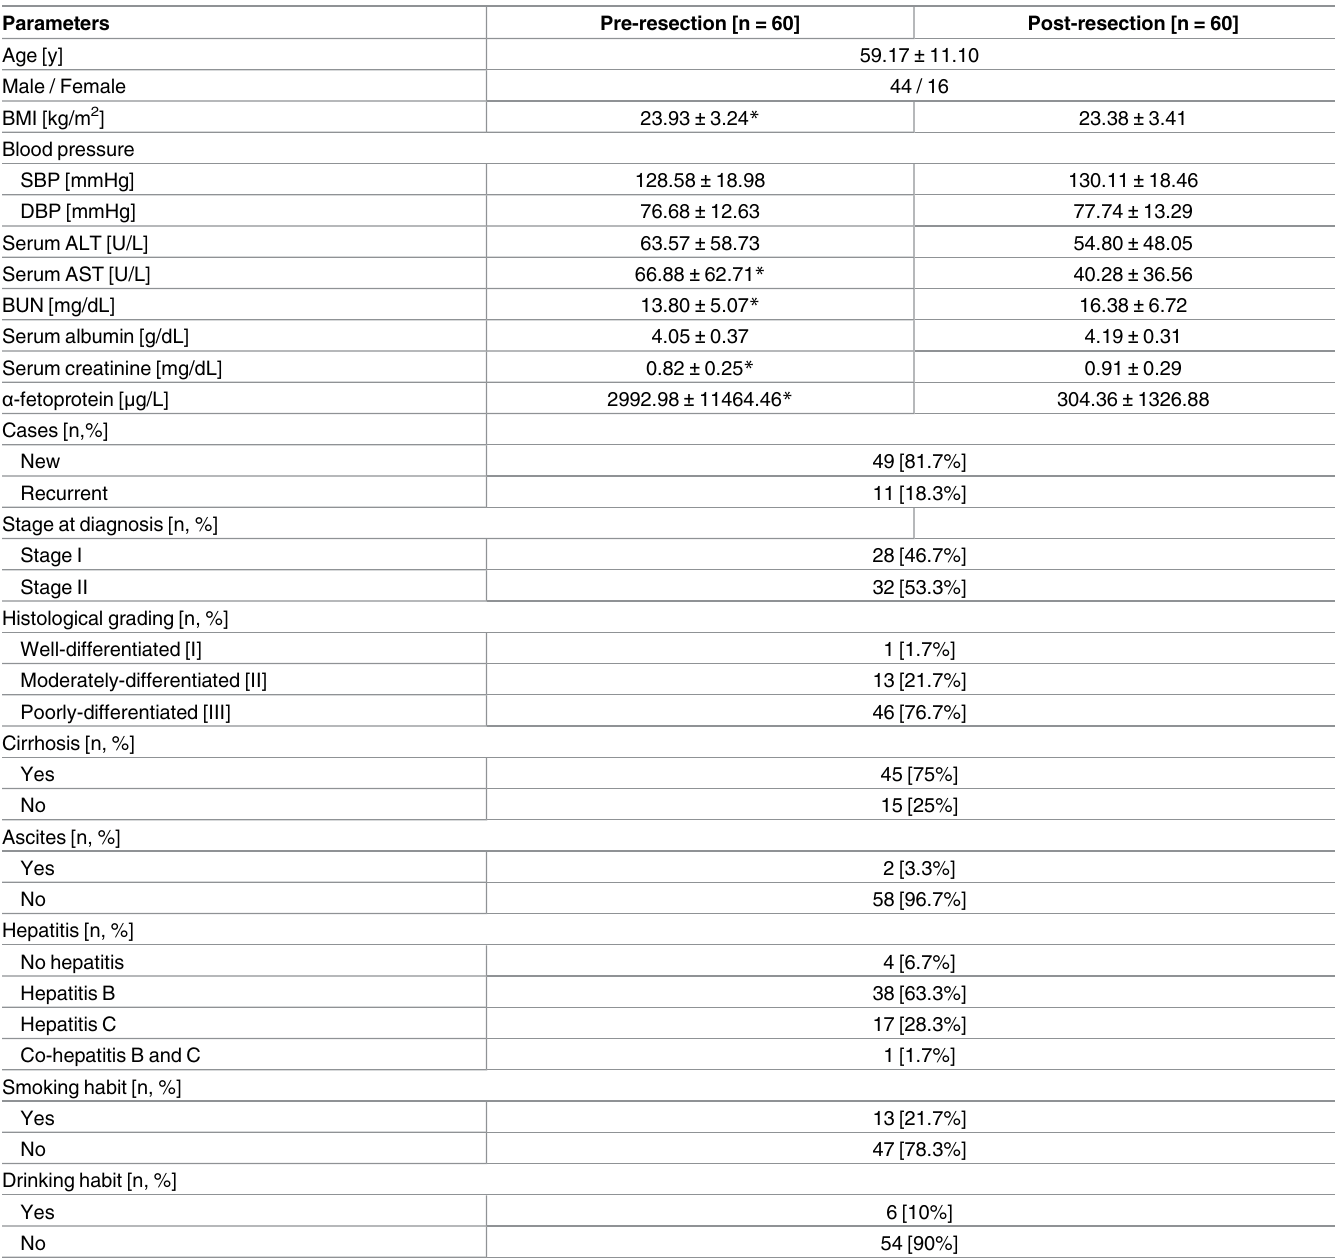
Table 1. Demographic and health characteristics of patients with hepatocellular carcinoma 1